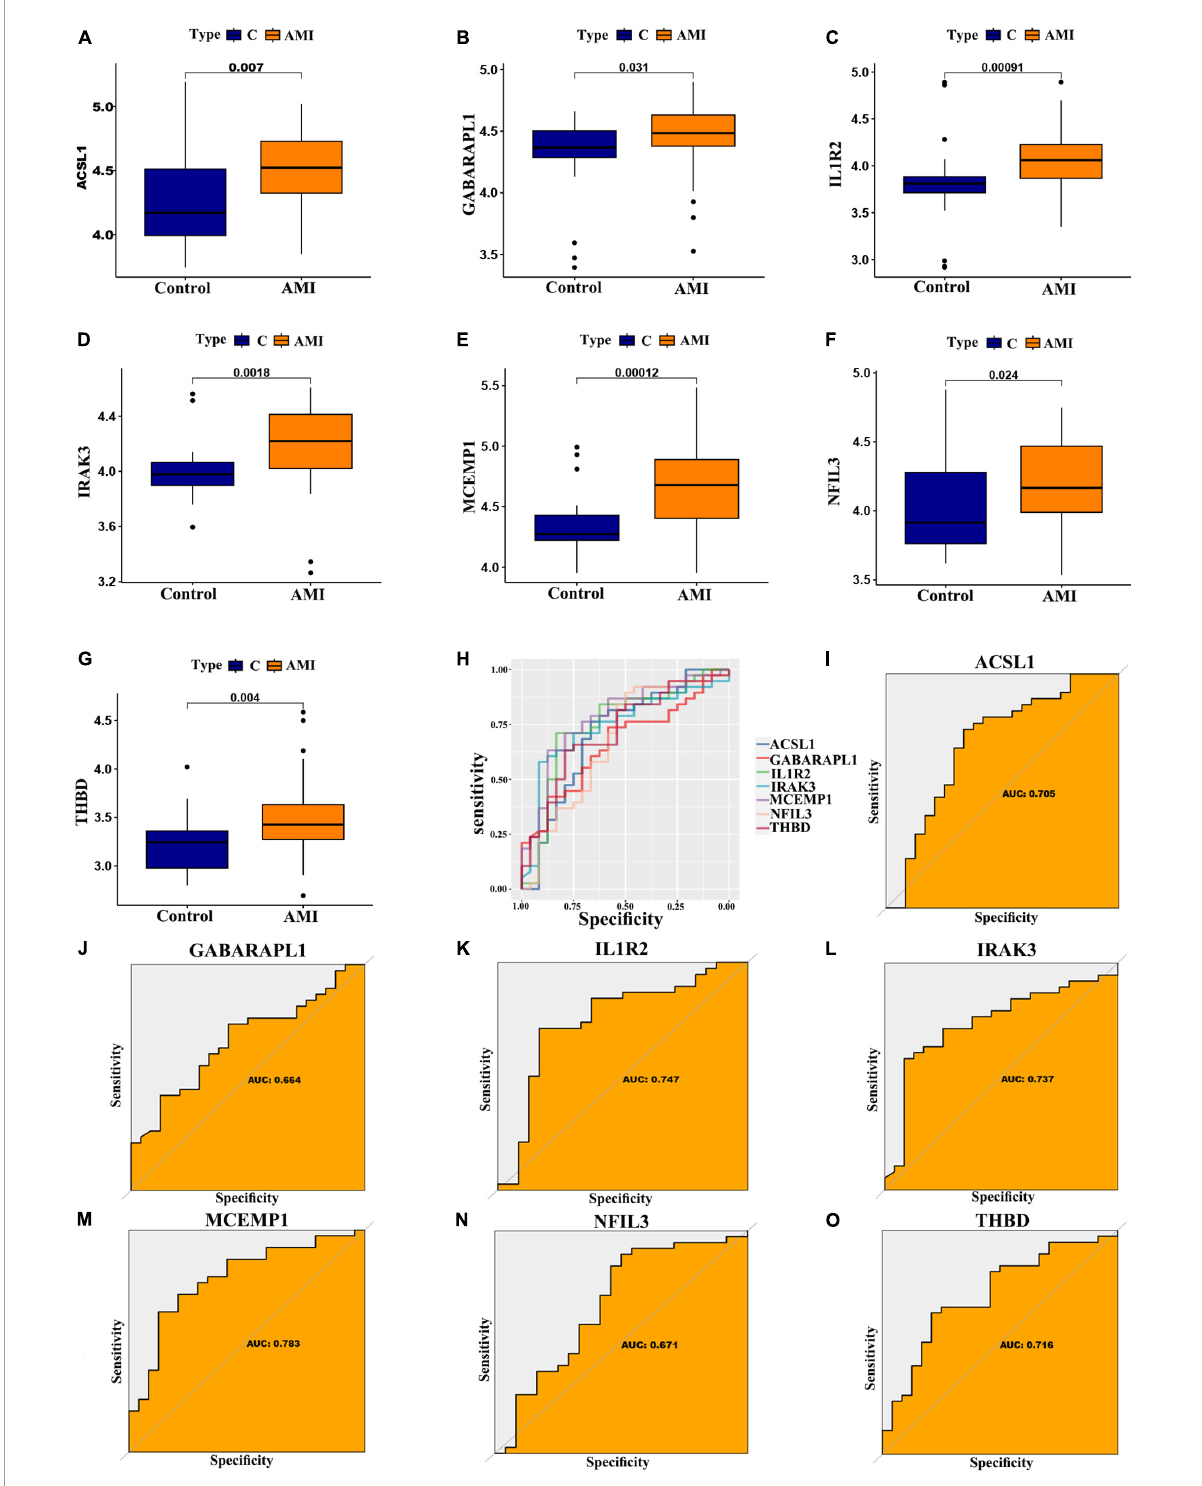
FIGURE7 Verification of expression and diagnostic efficacy for optimal feature genes using external validation dataset. (A–G) Box plots showing the expression of ACSL1 (A) , GABARAPL1 (B) , IL1R2 (C) , IRAK3 (D) , MCEMP1 (E) , NFIL3 (F) , and THBD (G) in control and AMI samples. Statistic tests: Wilcoxon rank-sum test. (H–O) Roc curves (H) estimating the diagnostic performance of ACSL1 (I) , GABARAPL1 (J) , IL1R2 (K) , IRAK3 (L) , MCEMP1 (M) , NFIL3 (N) , and THBD (O)